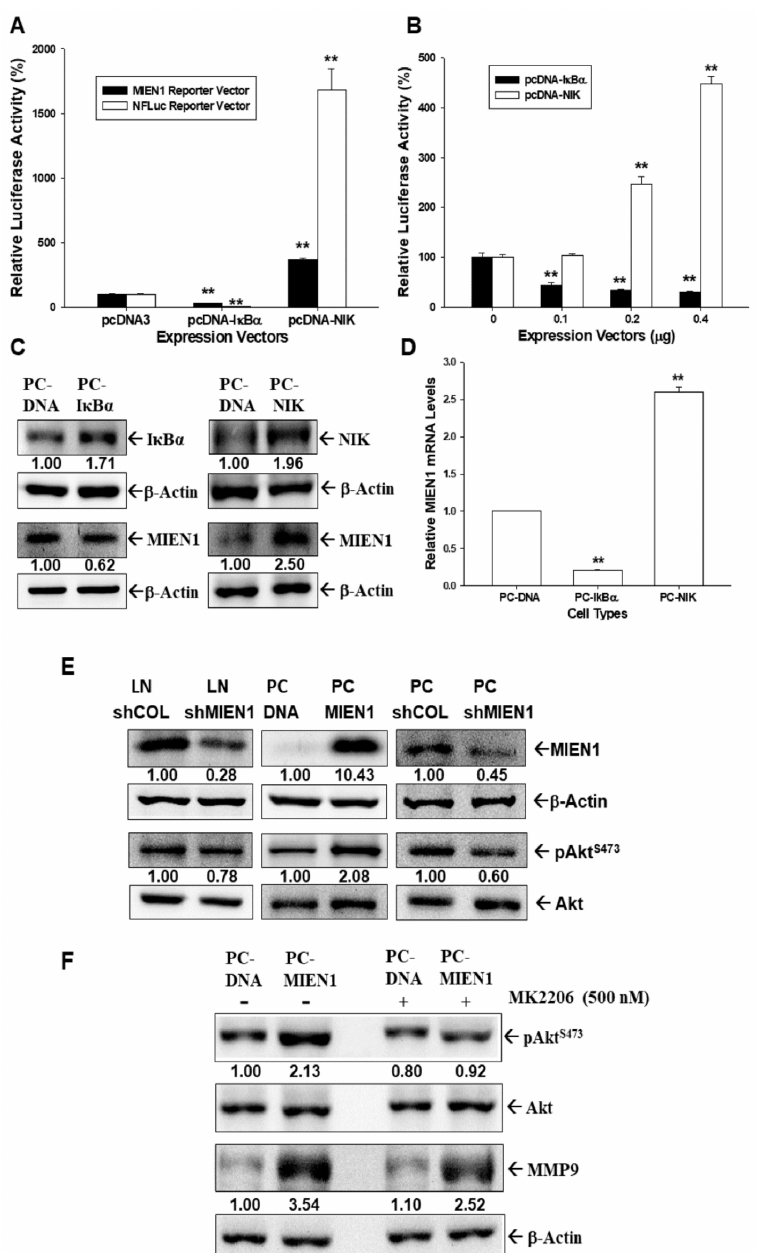
Figure 2. Modulation of migration and invasion enhancer 1 (MIEN1) by NF- κ B signaling in prostate carcinoma cells. ( A ) Relative luciferase activity of NF- κ B (NFLuc) and MIEN1 reporter vectors cotransfected with NF- κ B inhibitor α (I κ B κ ) or NF- κ B induced kinase (NIK) expression vectors as indicated in PC-3 cells. ( B ) Relative luciferase activity of MIEN1 reporter vector after cotransfection with various dosages of NIK or I κ B α expression vectors. Data are presented as mean percentage ± standard error (SE) ( n = 6) of the luciferase activity in relation to the vehicle-treated group (** p < 0.01). ( C ) Protein levels of I κ B α , NIK, and MIEN1 after ectopic I κ B α or NIK overexpression in PC3 cells. ( D ) Relative mRNA levels of MIEN1 in I κ B α - or NIK-overexpressing PC-3 cells ( ± SE, n = 3). ( E ) Protein levels of MIEN1, Akt, and pAkt S473 in PC-MIEN1, PC_shMIEN1, and LN_shMIEN1 cells in comparison to the mock-transfected control cells (PC-DNA, PC_shCOL, and LN_shCOL). ( F ) Protein levels of Akt, pAkt S473 , and matrix metallopeptidase 9 (MMP9) in PC-DNA and PC-MIEN1 cells after treatment with or without MK2206 (500 nM) for 24 h. The number indicates the ratio of target gene / β -Actin or pAkt S473 / Akt in relation to PC-DNA, LN-shCOL, or PC-shCOL